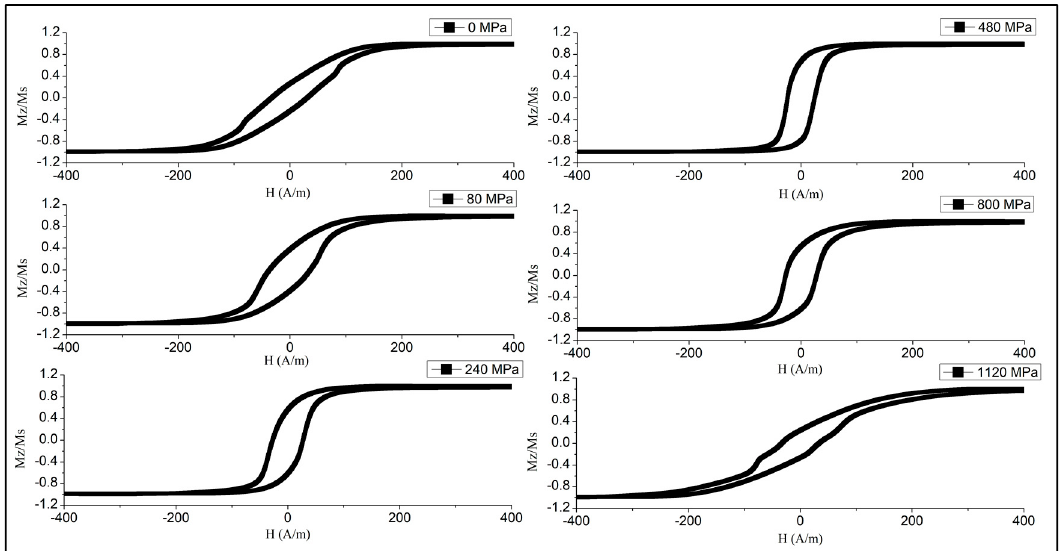
Figure 6. Effect of tensile stress on the hysteresis loops of glass-coated amorphous Co 71 Fe 5 B 11 Si 10 Cr 3 microwires after current annealing at 50 mA (corresponds to the current density of 102 A/mm 2 ) for 60 min.